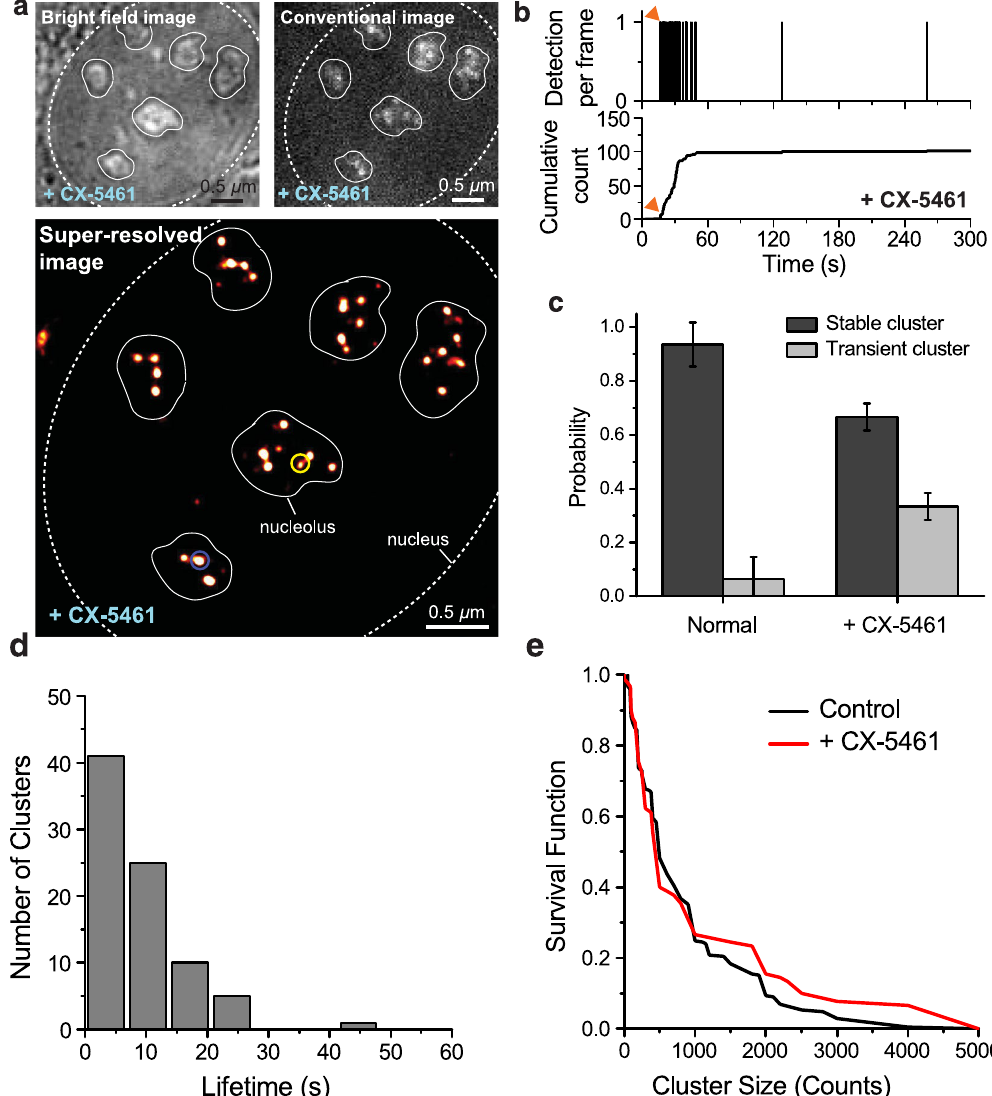
Figure 3. Pol I Response to CX-5461 Initiation Inhibition. ( a ) Bright-field, conventional and super-resolution reconstruction images of the Dendra2-RPA194 U2OS cell line after 48 hours of treatment with CX-5461. Sparse foci appear against a stronger background like in the untreated, interphase nucleus. Many dimmer foci that were not visible in the conventional image appear in the super-resolution reconstruction. ( b ) A sample time trace of a transient cluster (yellow circle in panel a) in the CX-5461 treated nucleus. The burst of detections occurs after a delay (~15 s, red arrow) after the beginning of acquisition, then abruptly stops, signatures of a transiently lived cluster (Supplementary Fig S3). ( c ) The fraction of stable vs. transient clusters in control and CX-5461 treated cells. ( d ) Histogram of transient cluster lifetimes in the CX-5461 treated cells. The mean lifetime is 8.7 ± 0.7 s. ( e ) Survival curve of stable clusters sizes for control and CX-5461 treated clusters. We analyzed a total of 10 cells imaged on three separate days. The cluster size is measured in counts, i.e., the number of localizations within the